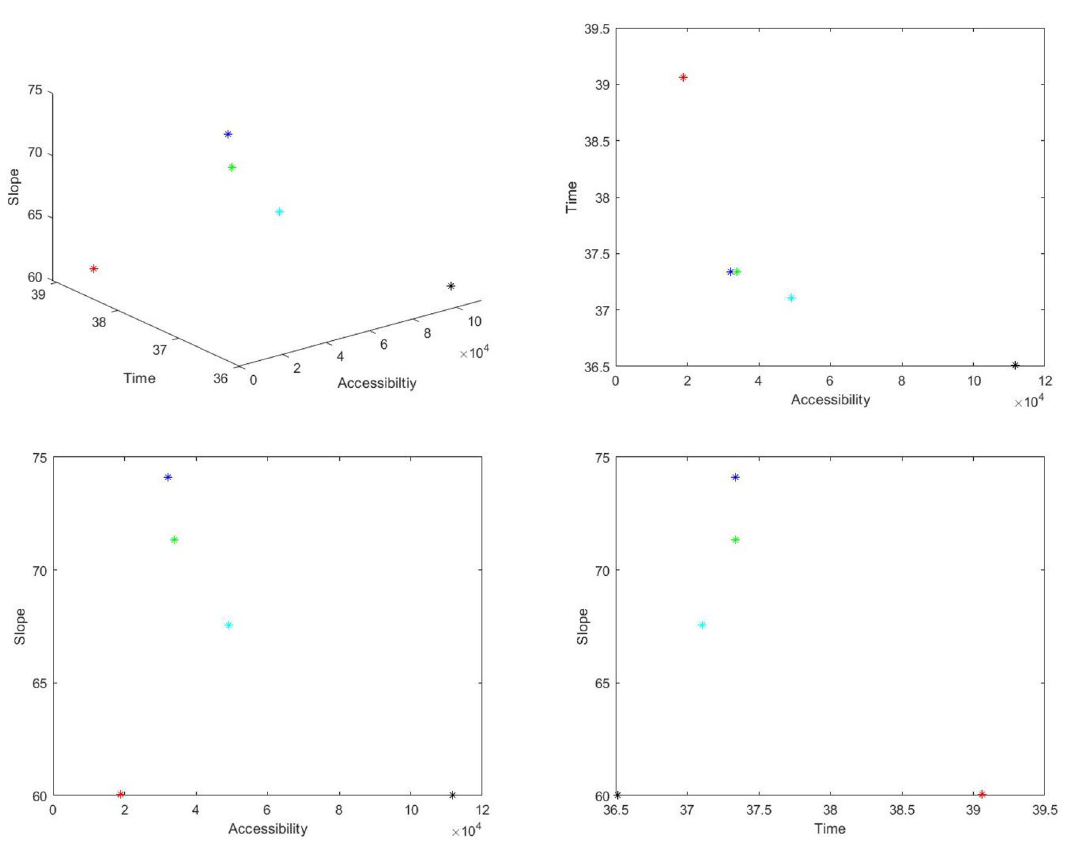
Fig. 7 Pareto Front of the Path L 2 considering the three objective